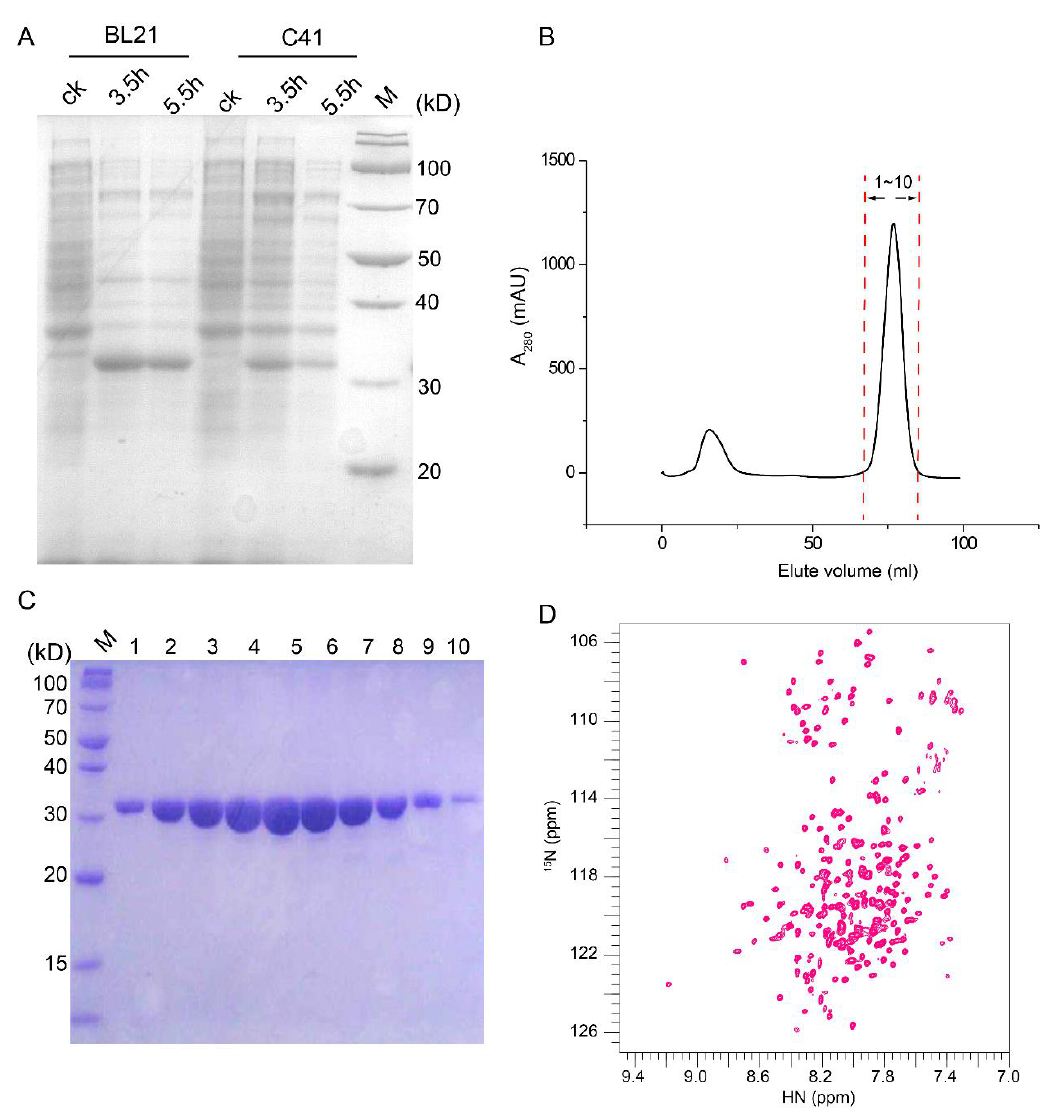
Figure 1. Protein purification and NMR sample preparation of CAC. ( A ) The effects of E. coli strains and culture time at the expression level of CAC at 37 ◦ C; ( B ) Size exclusion chromatography, column: HiLoad 16/600 SuperdexTM 200 pg, buffer: 30 mM MES, 20 mM NaCl, 0.1% DPC, pH = 6.0; ( C ) SDS-PAGE analysis of fractions in size exclusion chromatography; ( D ) 2D 1 H- 15 N TROSY-HSQC NMR spectrum of CAC in DPC micelles.